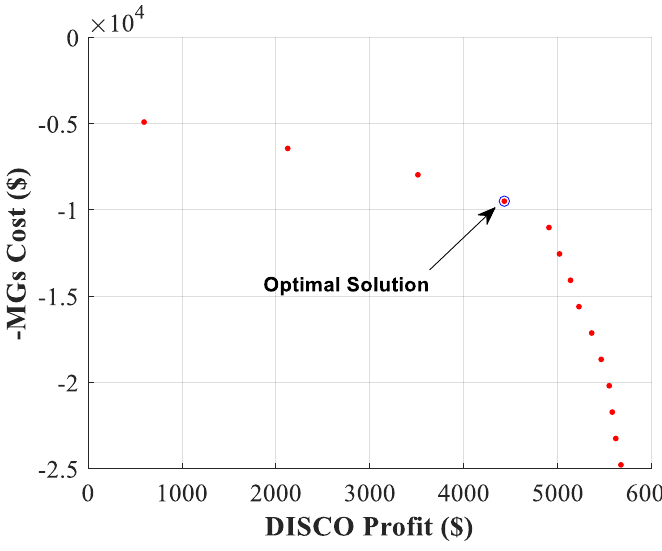
Figure 6. Pareto optimal front of DISCO profit and MGs Cost.